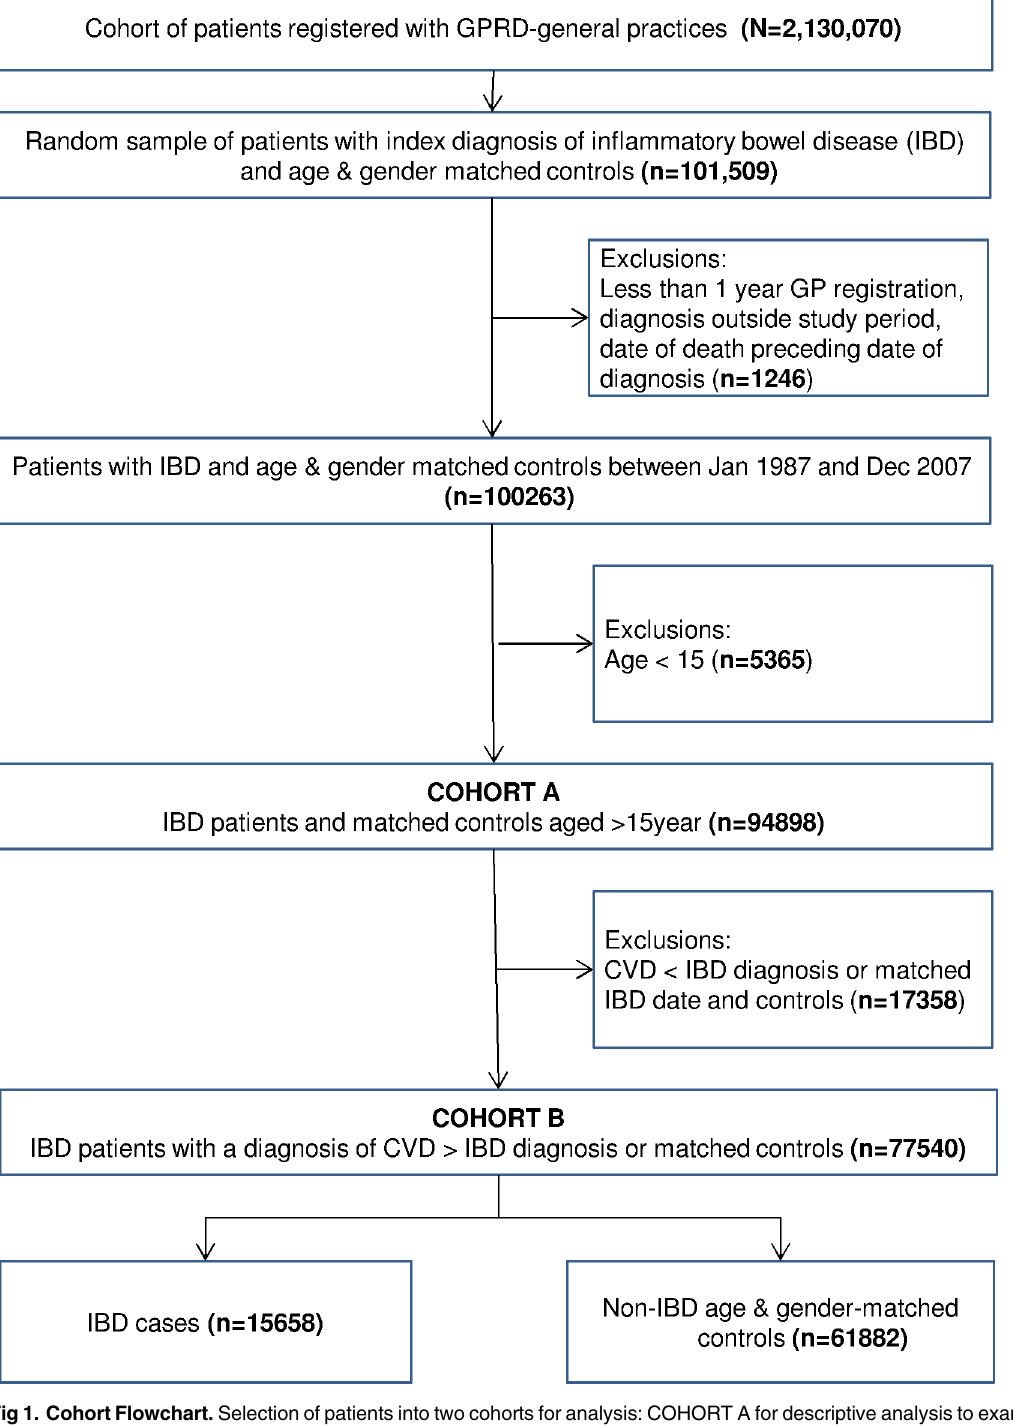
PLOS ONE | DOI:10.1371/journal.pone.0139745 October 13,